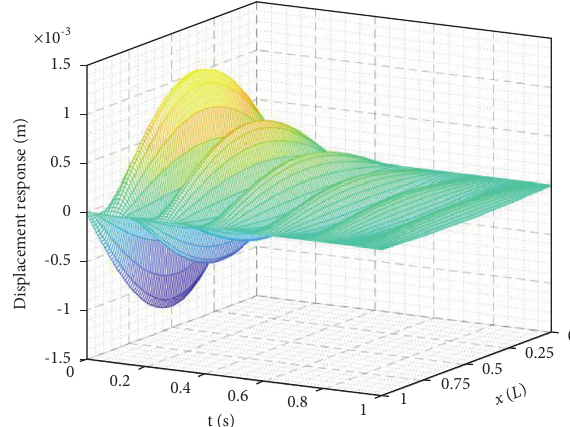
Figure 9: Time-domain response of the supporting